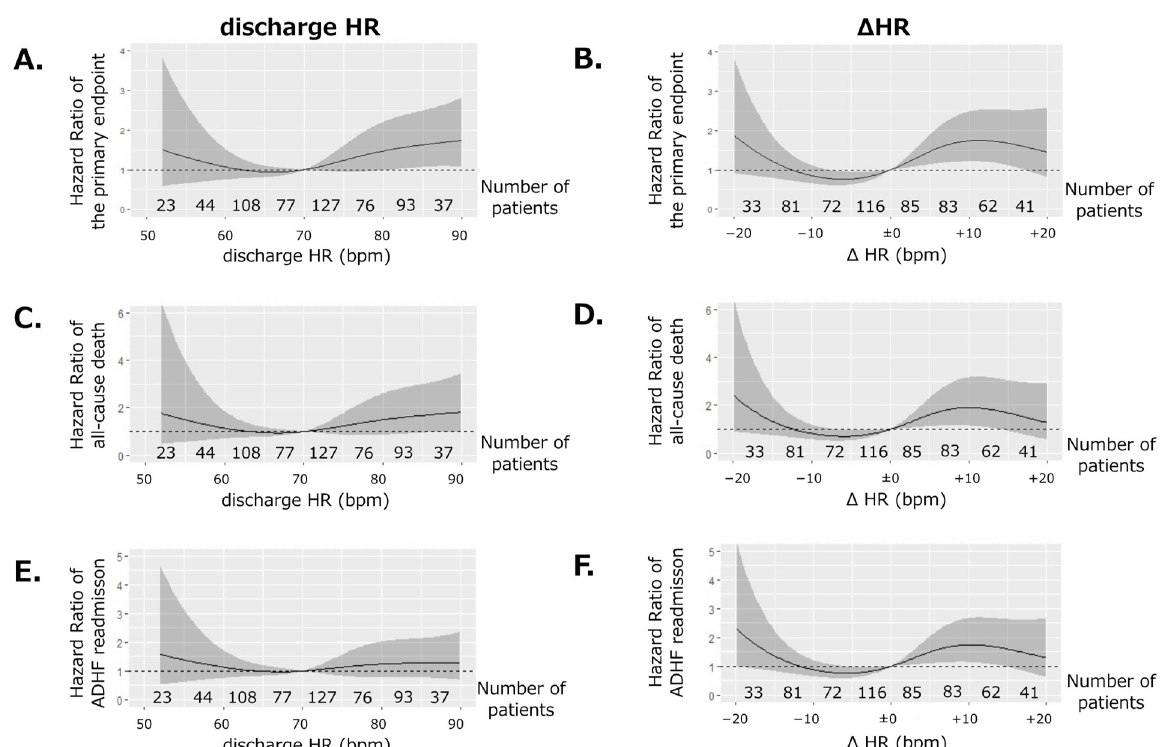
Figure 4. Restricted cubic spline analysis depicting the association of discharge HR or Δ HR with a hazard ratio of ( A , B ) the primary endpoint, ( C , D ) all-cause death, and ( E , F ) ADHF readmission. Δ HR was defined as the difference between discharge HR and THR. Hazard ratio was adjusted for the covariates shown in Figure 3B (age; sex; BMI; NHYA; eGFR; Na, Hb, and Alb levels; LVEF; and β -blocker prescription). HR: heart rate at discharge, THR: target heart rate, BMI: body mass index, NYHA: New York Heart Association functional class, eGFR: estimated glomerular filtration rate, Hb: hemoglobin level, Na: serum sodium level, Alb: serum albumin level, LVEF: left ventricular ejection